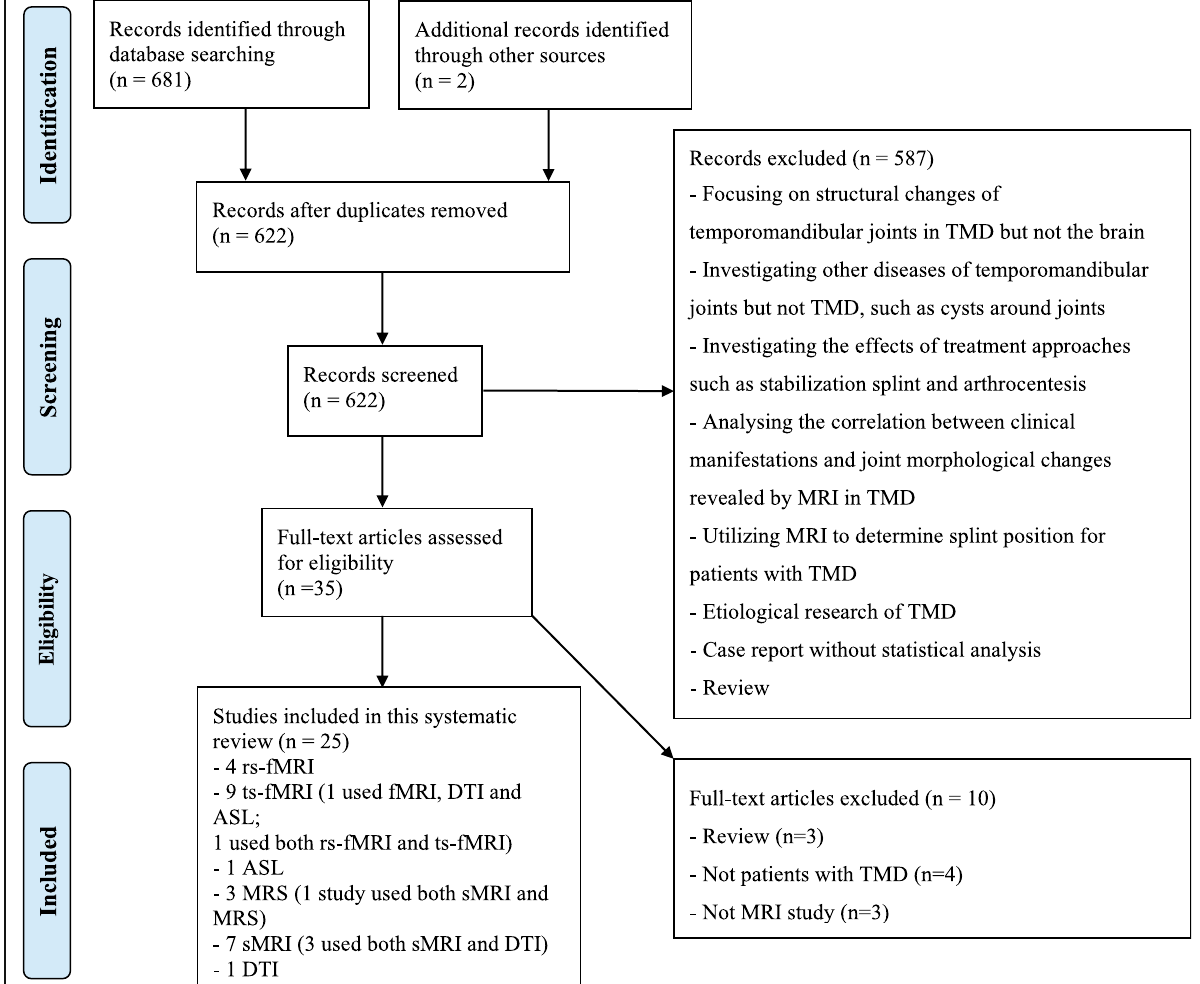
Fig. 1 Flowchart of the selection procedure. Abbreviations: TMD, temporomandibular disorders; MRI, magnetic resonance imaging; fMRI, functional MRI; sMRI, structural MRI; rs-fMRI, resting-state fMRI; ts-fMRI, task-state fMRI; ASL, arterial spin labeling; MRS, magnetic resonance spectroscopy; DTI, diffusion tensor